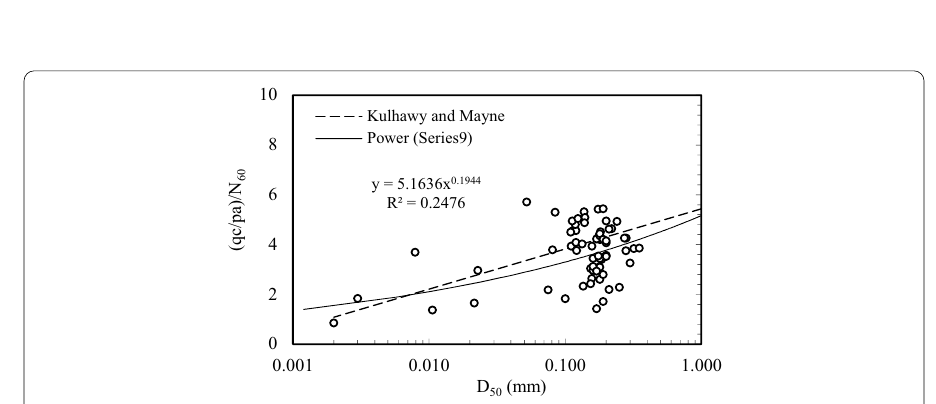
y = 5.1636x 0.1944 R² = 0.2476